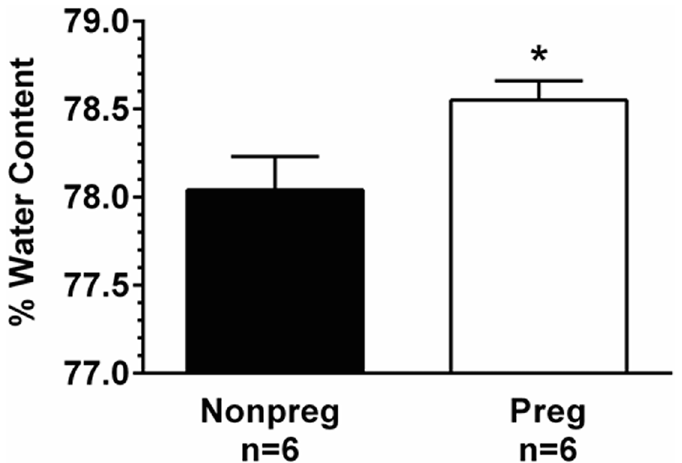
Fig 5. The effect of seizure on vasogenic edema formation in nonpregnant (Nonpreg) and late- pregnant (Preg) rats. Percent water content of the posterior cerebral cortex was significantly higher after seizure in Preg compared to Nonpreg rats. * p < 0.05 vs. Nonpreg using Student ’ s